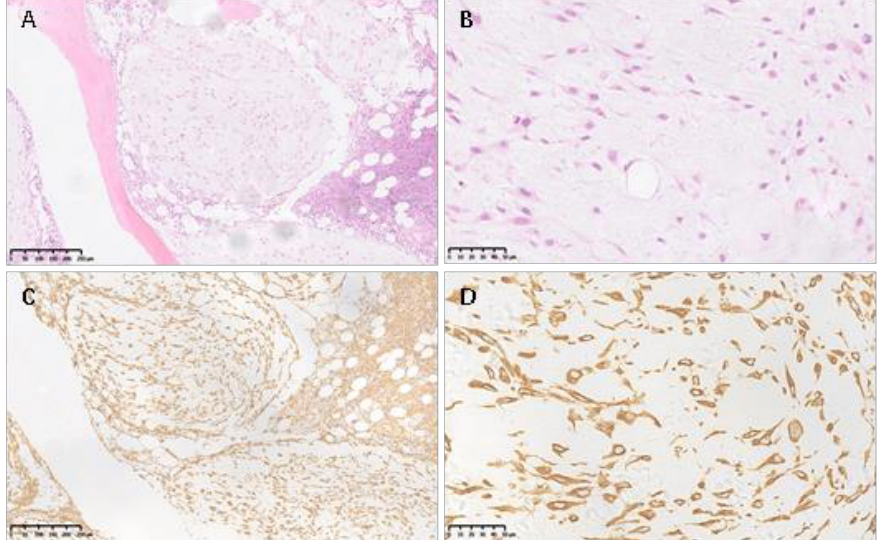
Figure 4. Hematoxylin – eosin staining of T11 paravertebral tissue showed nodular calcification and osteogenesis separated by cells rich in septa ( A , 100×). Under high-power microscopy ( B , 400×), tumor cells were loosely aggregated in myxoid stroma and osteoid was produced, and nuclei heteromorphism can be found. Vimentin staining of the same section was positive ( C , 100×; D , 400×).